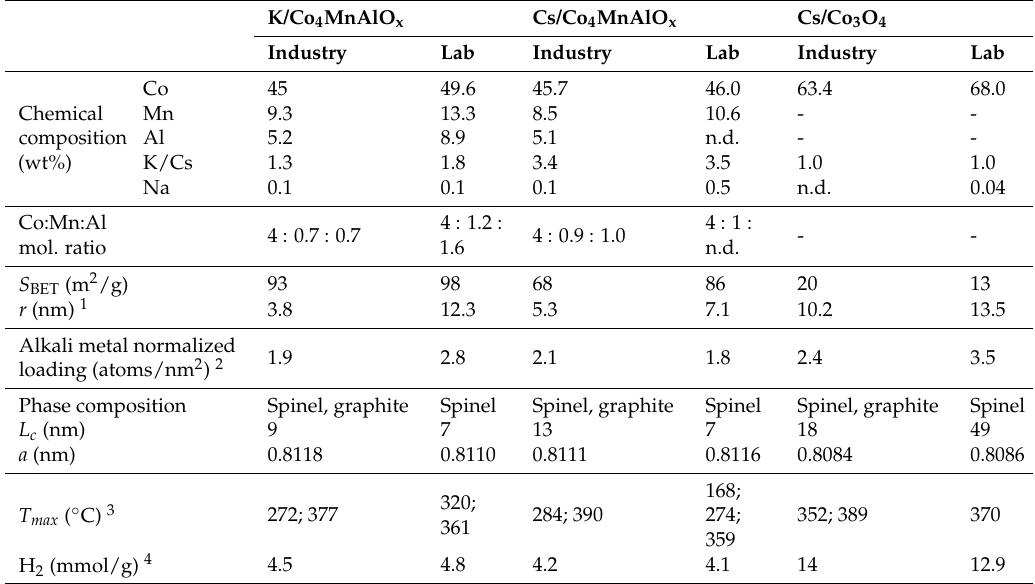
Table 2. Physicochemical properties of laboratory and commercially prepared